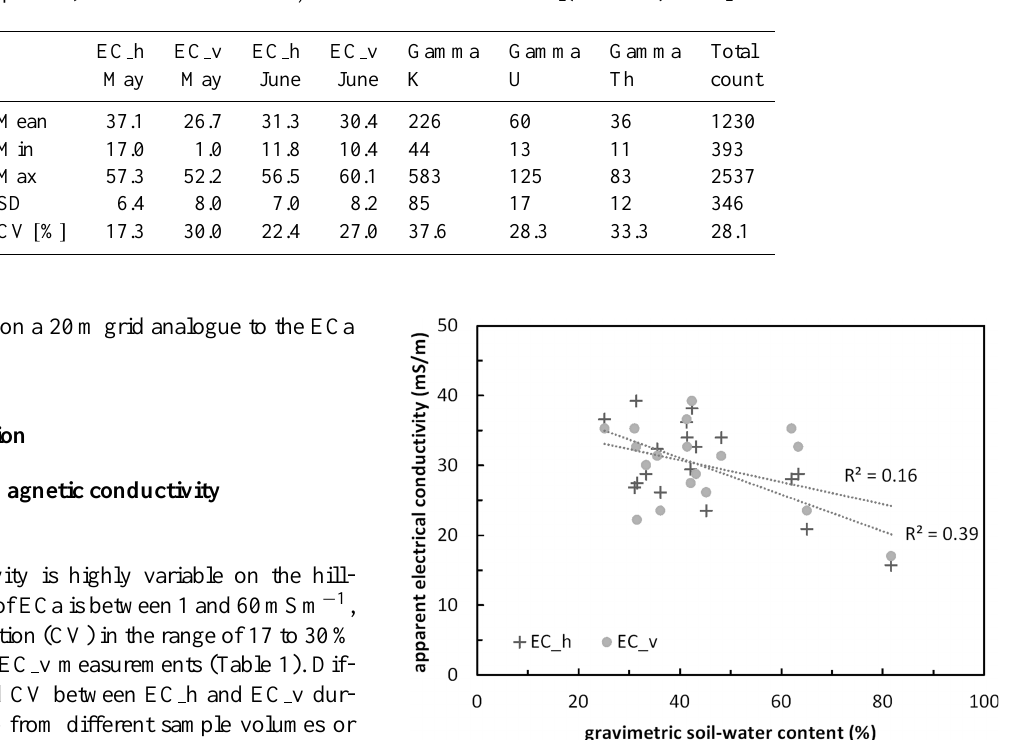
Table 1. Descriptive statistics of EMI measurements (in mSm − 1 ) in horizontal (EC h) and vertical (EC v) dipole configuration and gamma- ray spectroscopy (in counts per 60s). SD: standard deviation, CV: coefficient of variation [(SD/Mean) × 100].